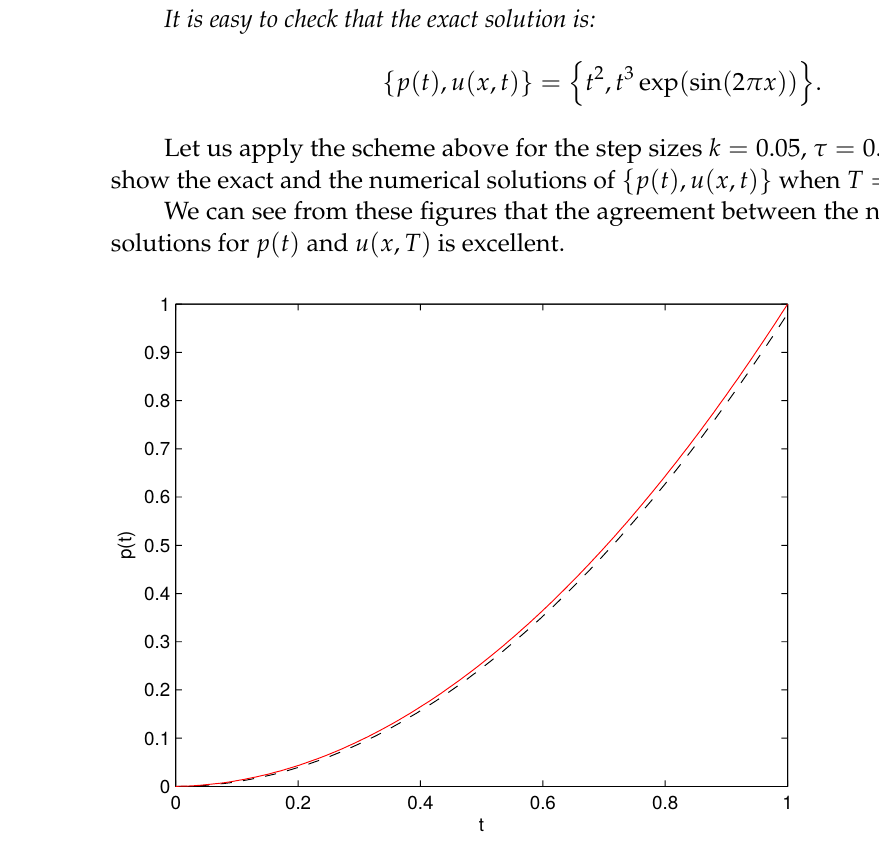
Figure 1. The exact and numerical solutions of p ( t ) . The exact solution is shown with dashes line.